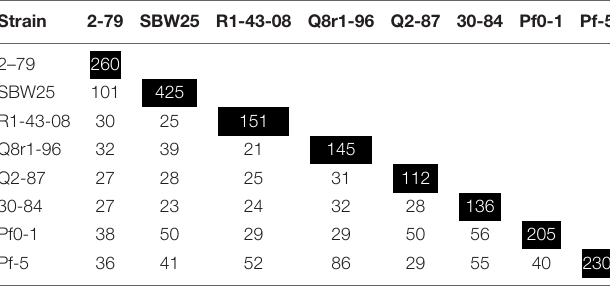
TABLE 1 | The number of differentially expressed genes shared among the eight studied strains of rhizosphere Pseudomonas .